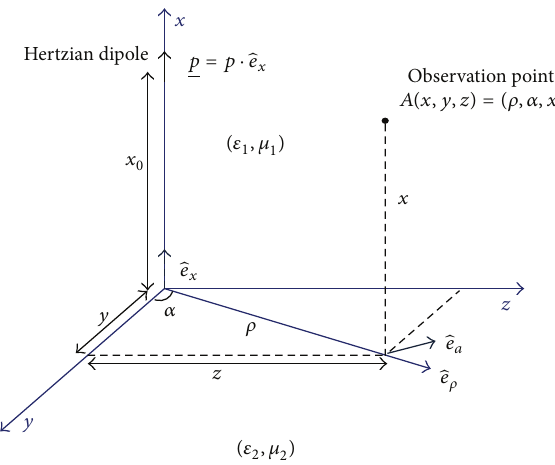
Figure 1: Geometry of the radiation problem considered in this paper. The radiating dipole is at position ( 𝑥 0 ,0,0 ) above infinite, flat, and lossy ground situated at plane 𝑥 = 0